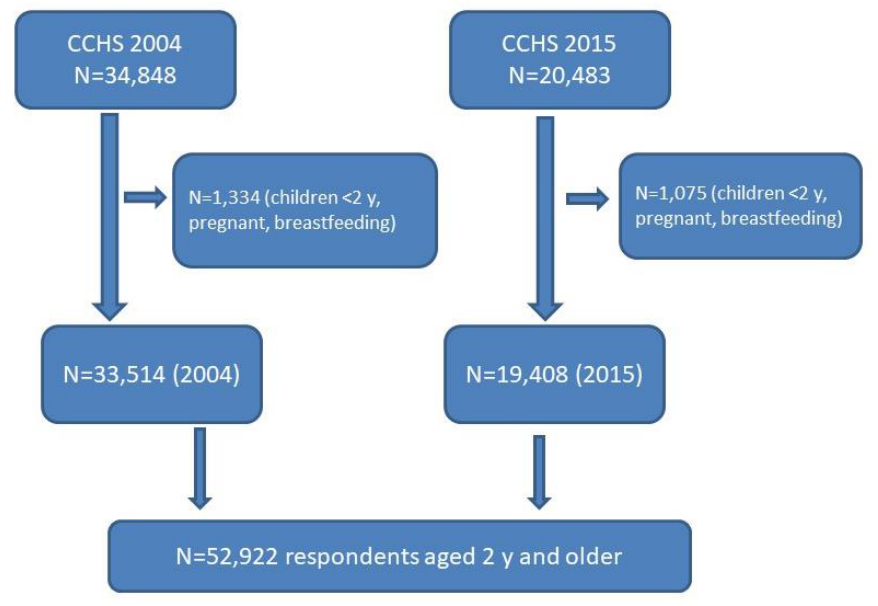
Figure 1. Analytical sample.